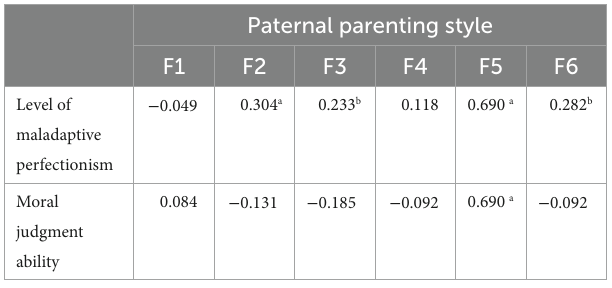
TABLE 4 Correlation between parental rearing style and perfectionism and moral judgment ability of OCD patients (r